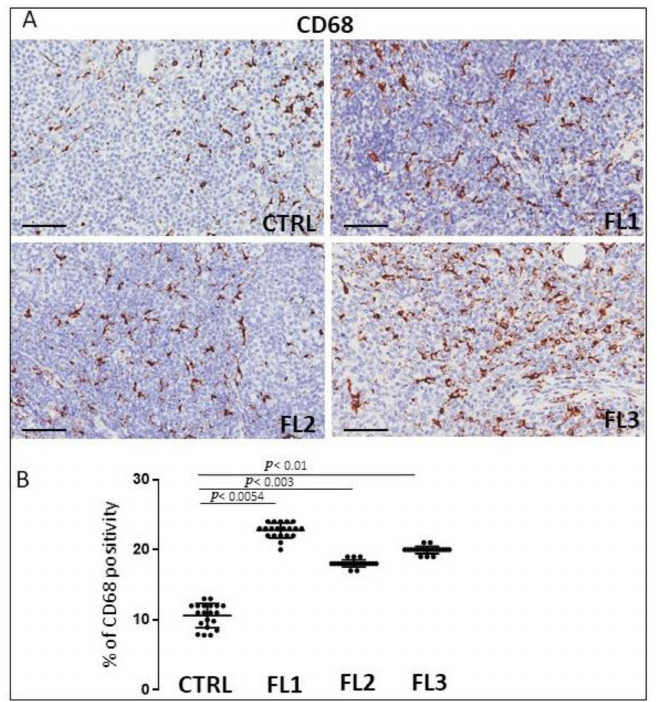
Figure 1. Immunohistochemical staining for CD68 in FL grade1 (FL1), FL grade2 (FL2), and FL grade 3 (FL3) and control samples (CTRL) ( A ). Scale bar: 60 µ m ( A ). Morphometric analysis indicates the percentage of CD68 positivity in FL and CTRL samples ( B ).